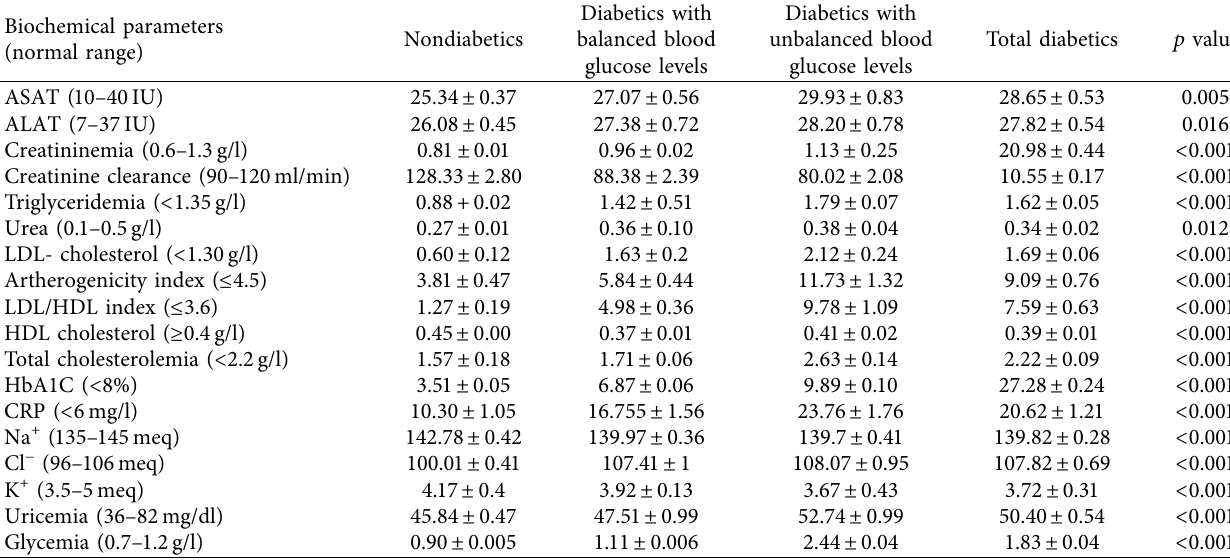
Table 4: Mean values of biochemical parameters as function of diabetic status. Biochemical